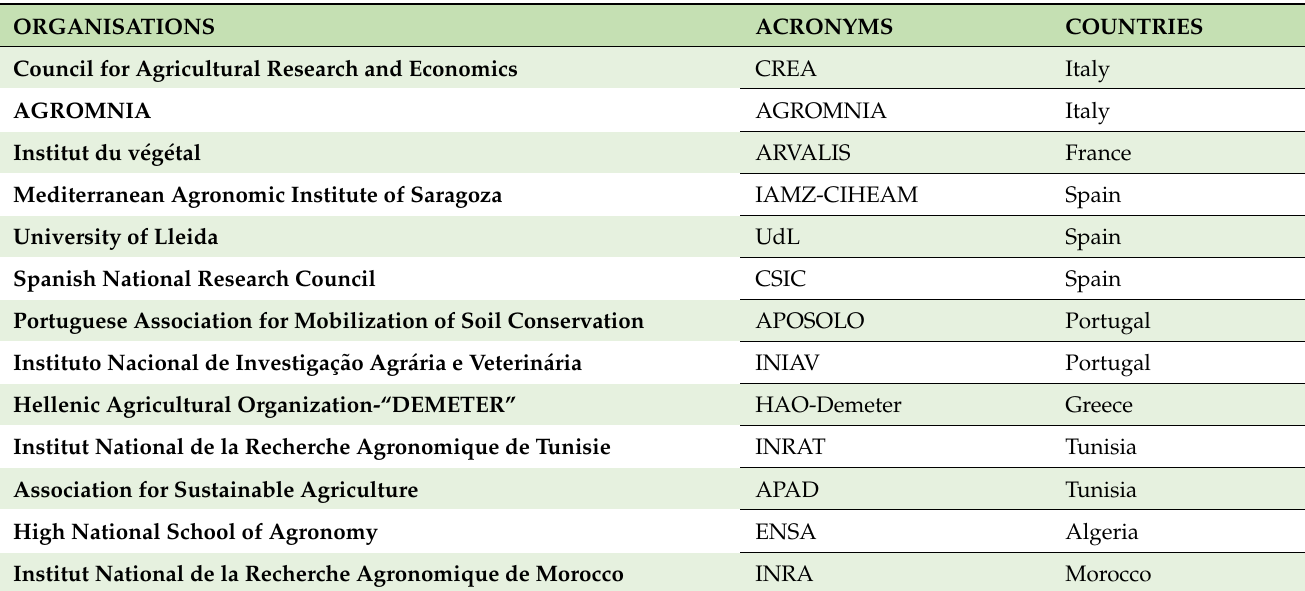
Table 2. Partners of the CAMA project.